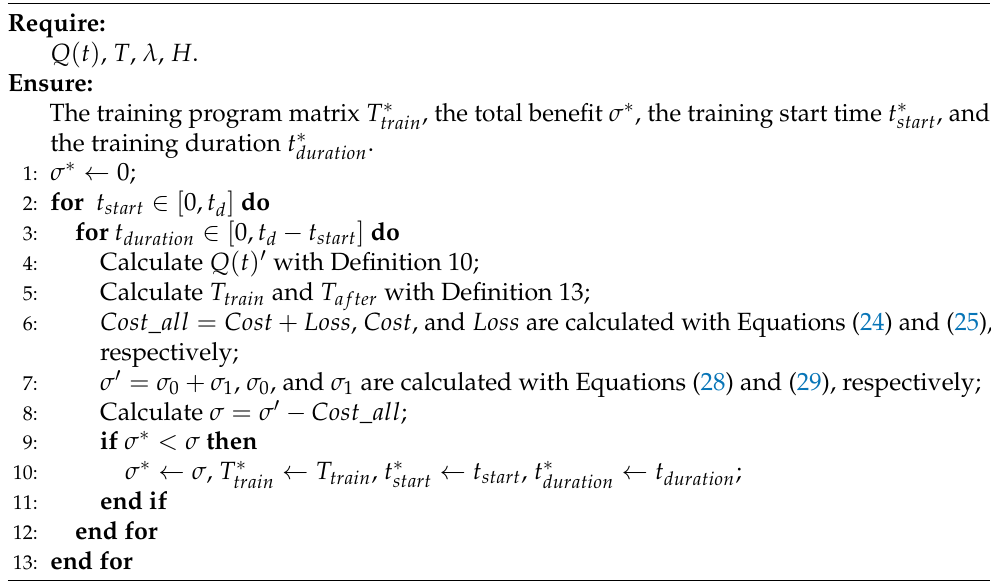
Algorithm 1 The algorithm for the GRATPC problem